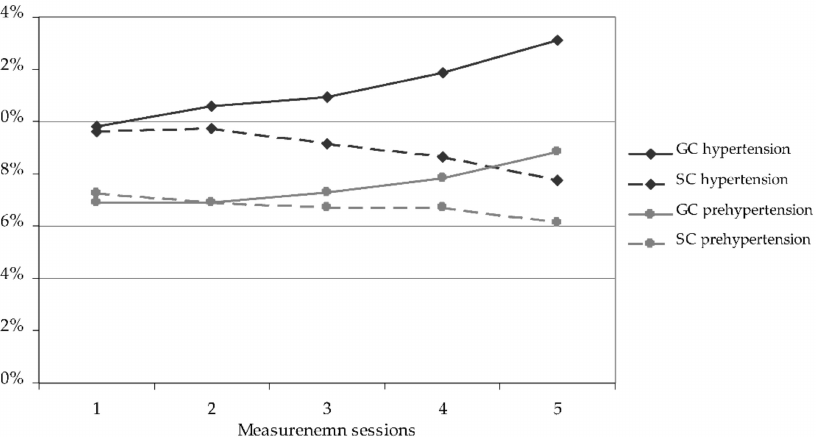
Figure 1. Changes in the percentage of children with systolic prehypertension and hypertension during the course of the study. GC—general education classes (standard PE, 4 h a week); SC—sport classes (elevated PE, 10 h a week).